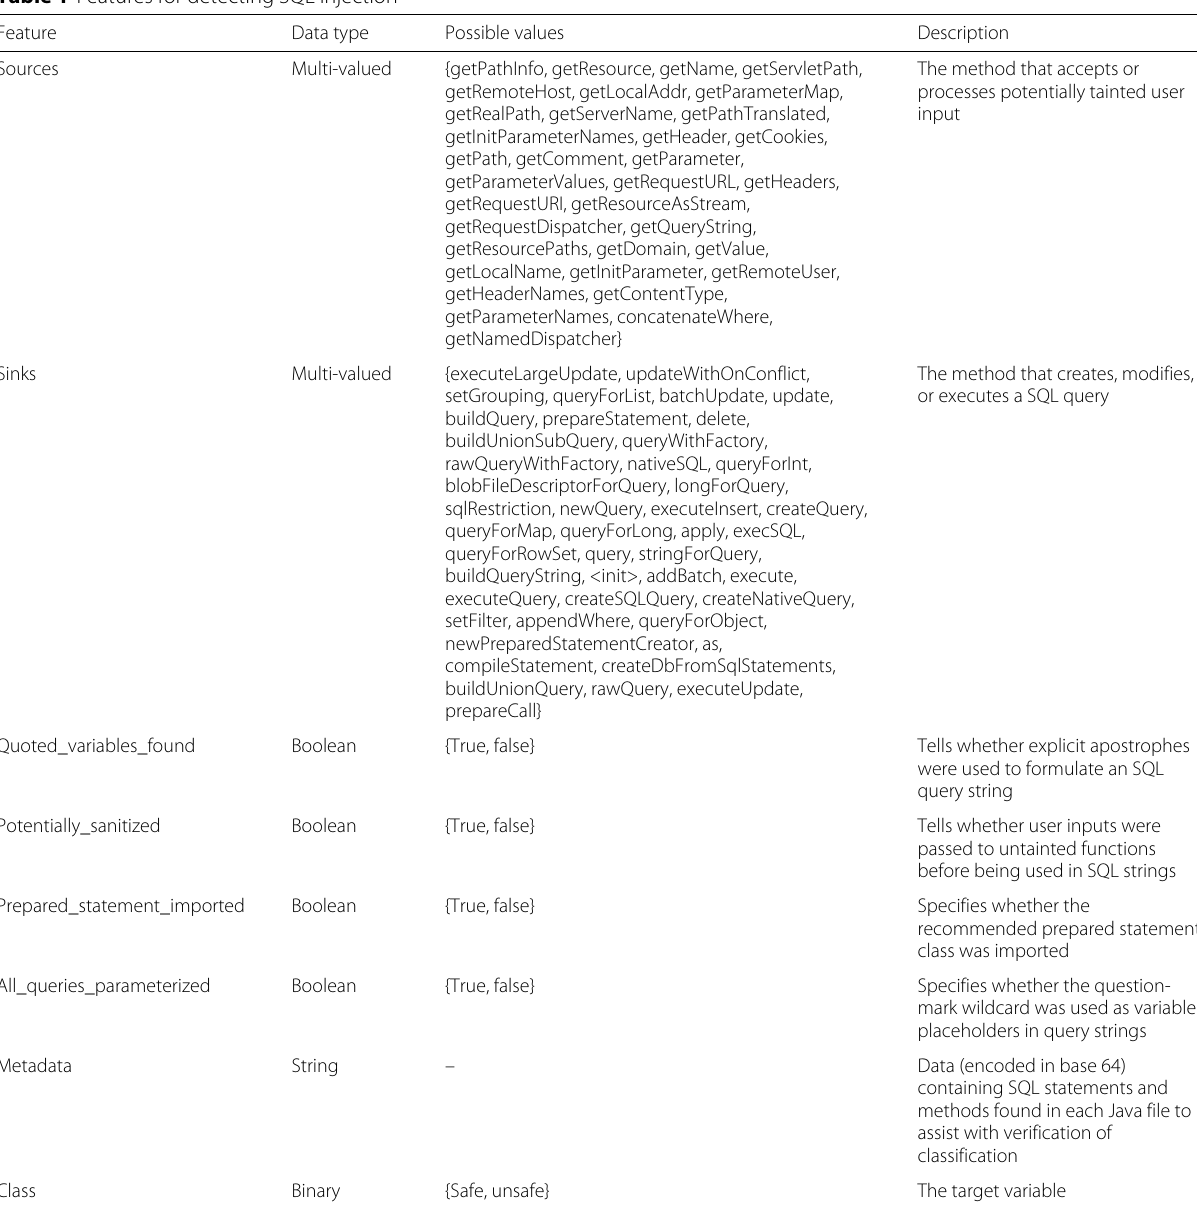
Table 1 Features for detecting SQL injection